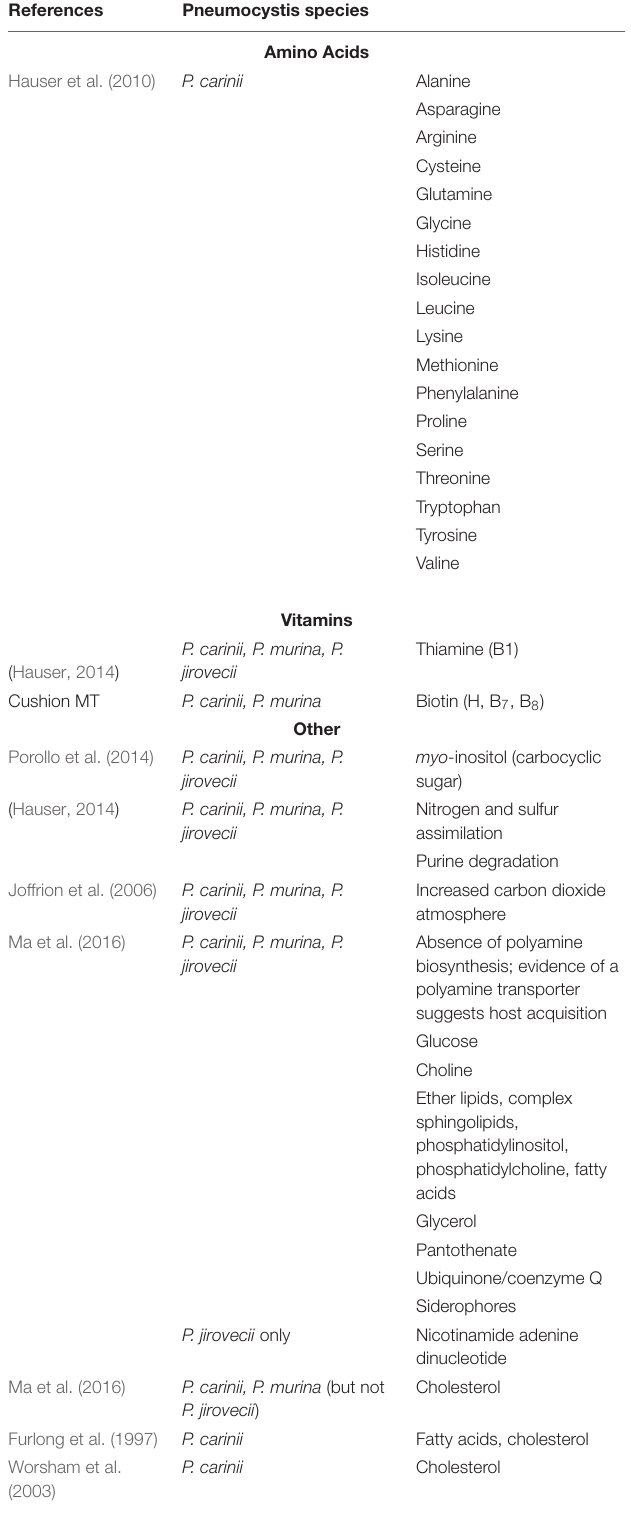
TABLE 3 | Predicted nutritional supplements indicated by absent genes and